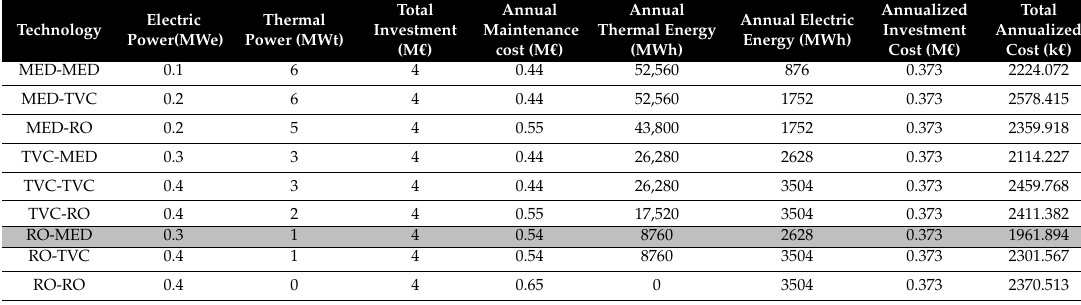
Table A5. Cost breakdown.